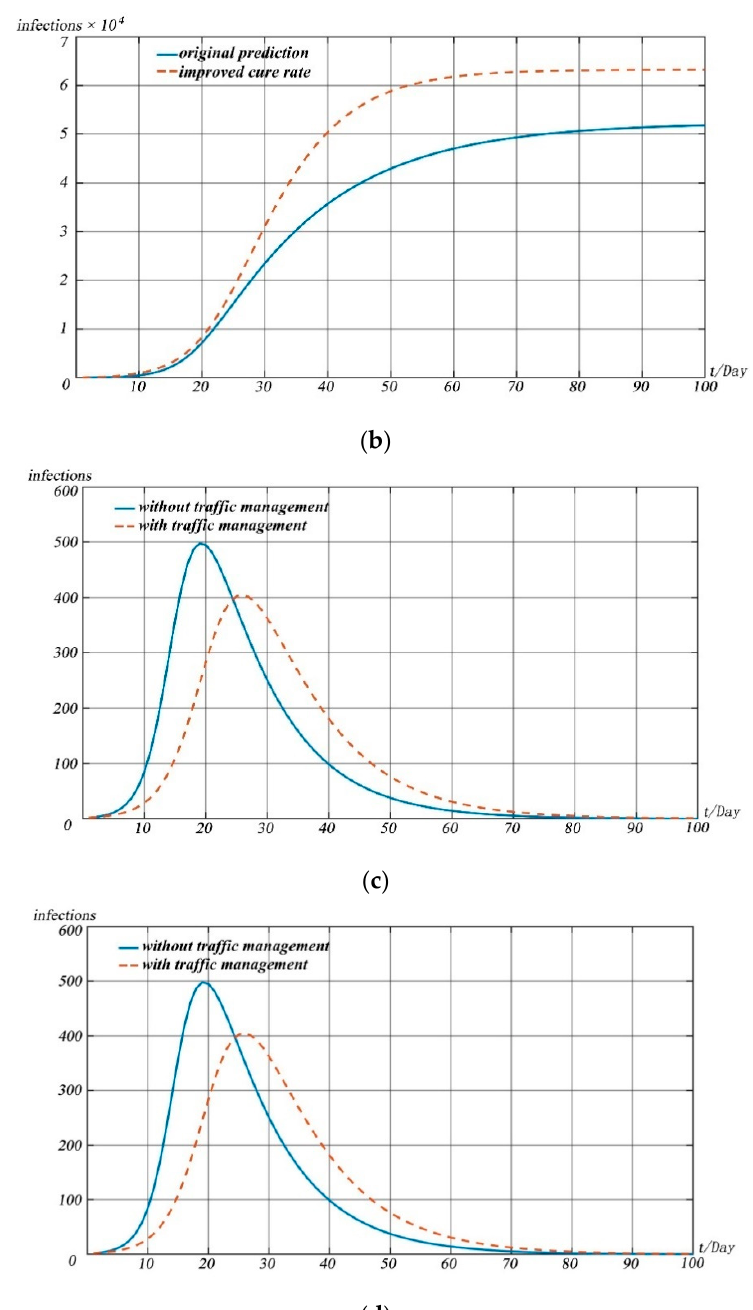
Figure 11. Model simulations. ( a ) Change in recovered people with different cure rates; ( b ) change in deaths with different cure rates; ( c ) change in infected people with the impact of traffic management; ( d ) change in infected people with the impact of interventions.